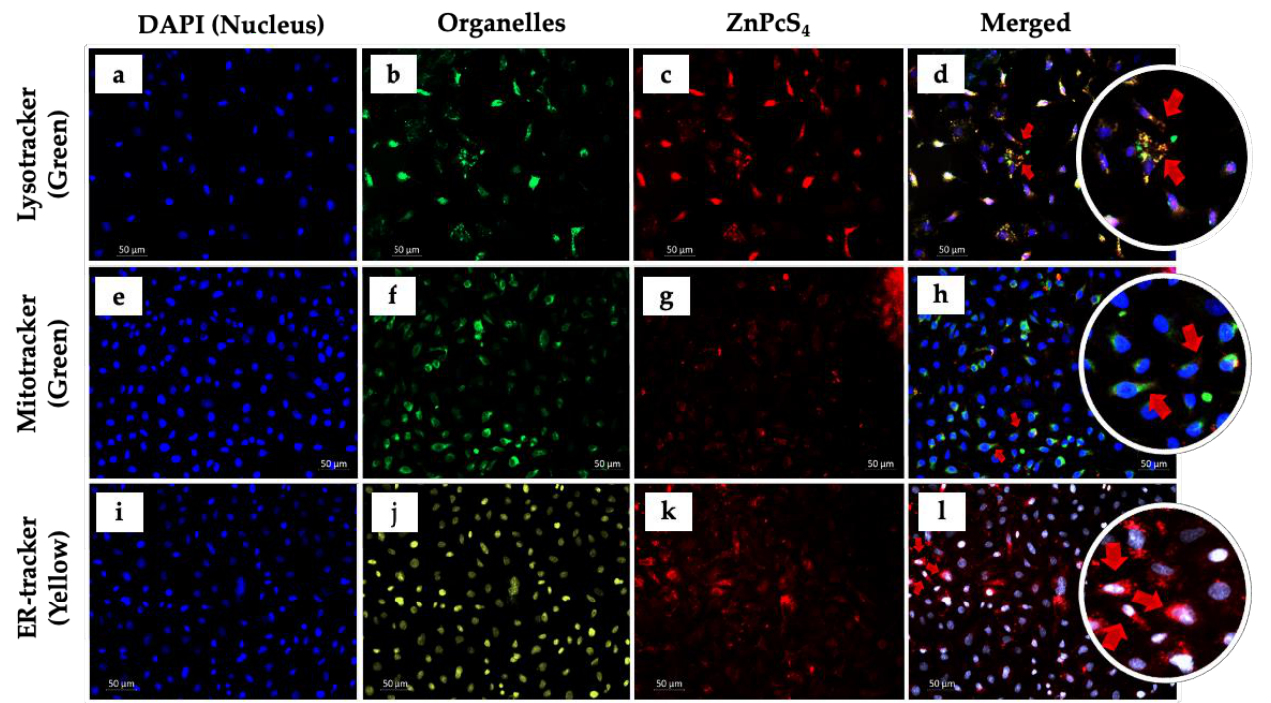
Figure 2. Intracellular co-localization of ZnPcS 4 PS in A549 cells. Fluorescence micrographs of A549 cells showing blue fluorescence of DAPI ( a , e , i ), green fluorescence of Lysotracker ( b ) and Mitotracker ( f ), yellow fluorescence of ER tracker ( j ), red fluorescence of ZnPcS 4 ( c , g , k ) and the merged image of ZnPcS 4 and the organelle probes ( d , h , l ). (200× magnification and scale bar: 50 μm).